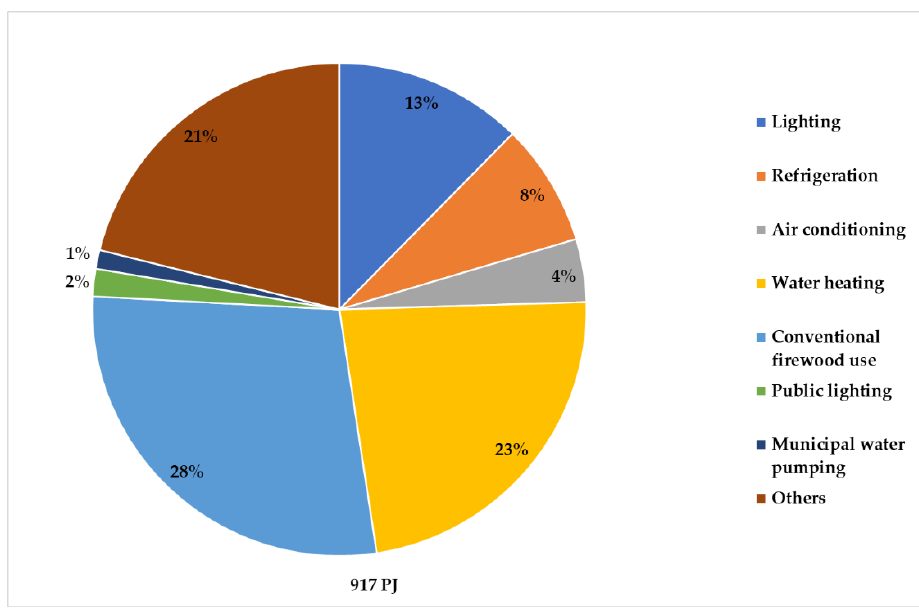
Figure 1. Structure of end-use of energy RCPS sectors. Source: Own calculation based on References